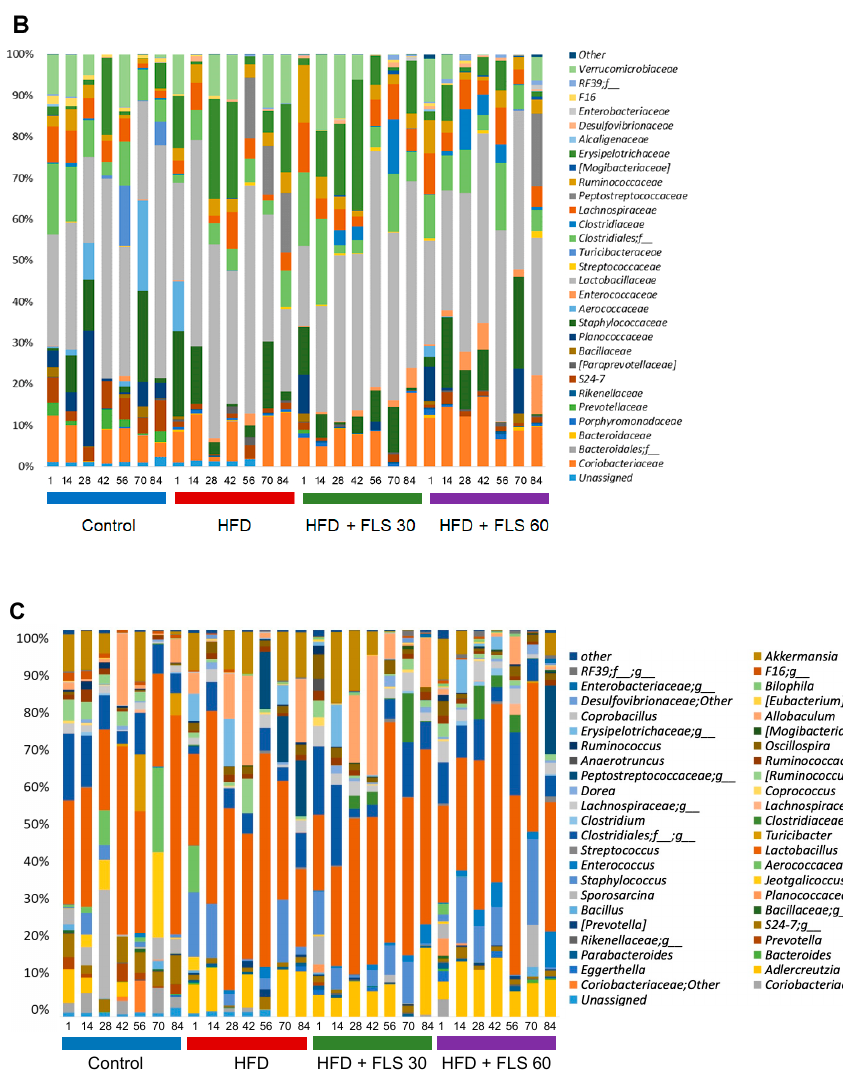
Figure 8. Impact of FLS on the composition of the gut microbiota of HFD-fed mice. Bar plots showing the relative abundance of major phyla ( A ), families ( B ) and genera ( C ) in the gut microbiota of mice receiving a standard diet (blue) or a HFD in the absence (red) or in the presence of FLS at 30 mg/die (green) or 60 mg/die (purple). For each group, the profiles are shown in chronological order (i.e., from day 1 to day 84 of treatment). Only taxa with mean relative abundance ≥ 0.1 in all mice are shown.